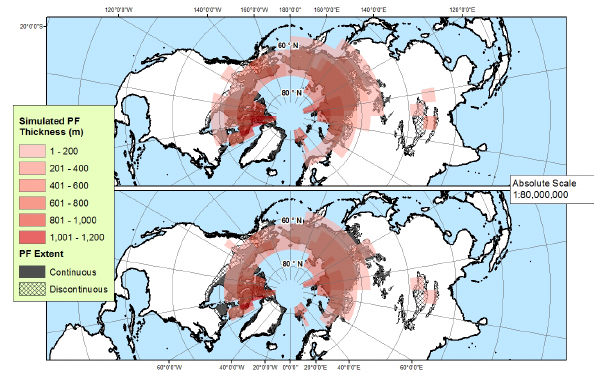
Figure 7. Preindustrial simulation results for permafrost thick- ness distribution using ECBilt–VAMPER semi-coupling (top) and ECBilt–VAMPER S semi-coupling